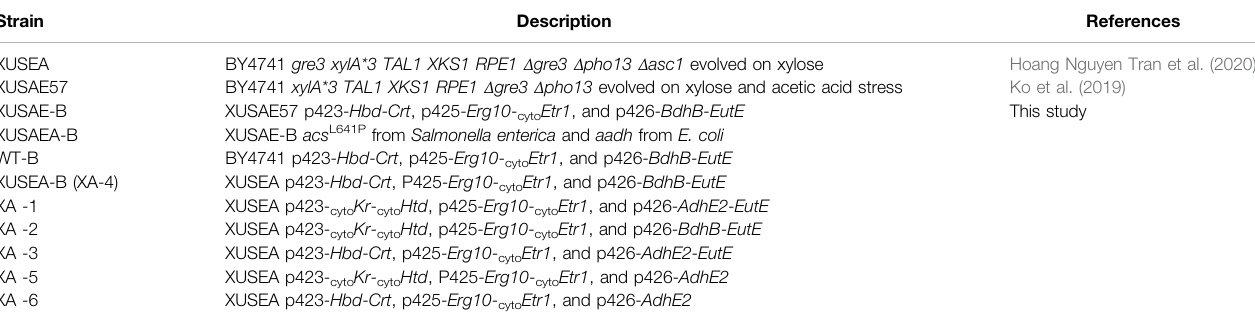
TABLE 1 | Strains used in this study.